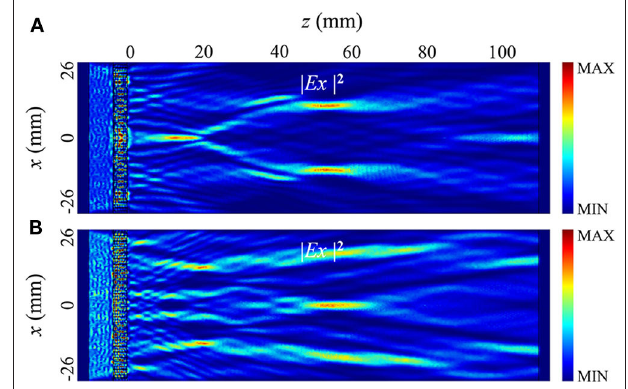
FIGURE 4 | Simulated intensity distributions of (A,B) double-spot and tri-spot focusing, respectively, with a focal length of